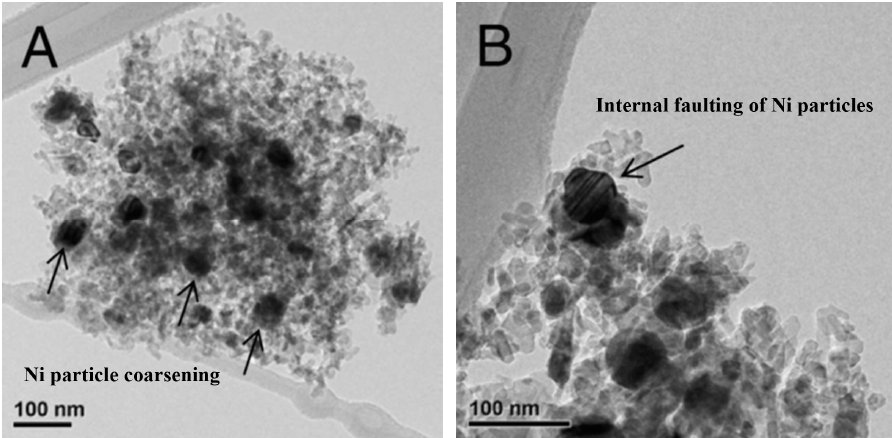
Figure 5. Ni particle coarsening failure: ( A ) Ni particle coarsening. ( B ) Internal faulting of Ni particles. Adapted with permission from Ref. [20].